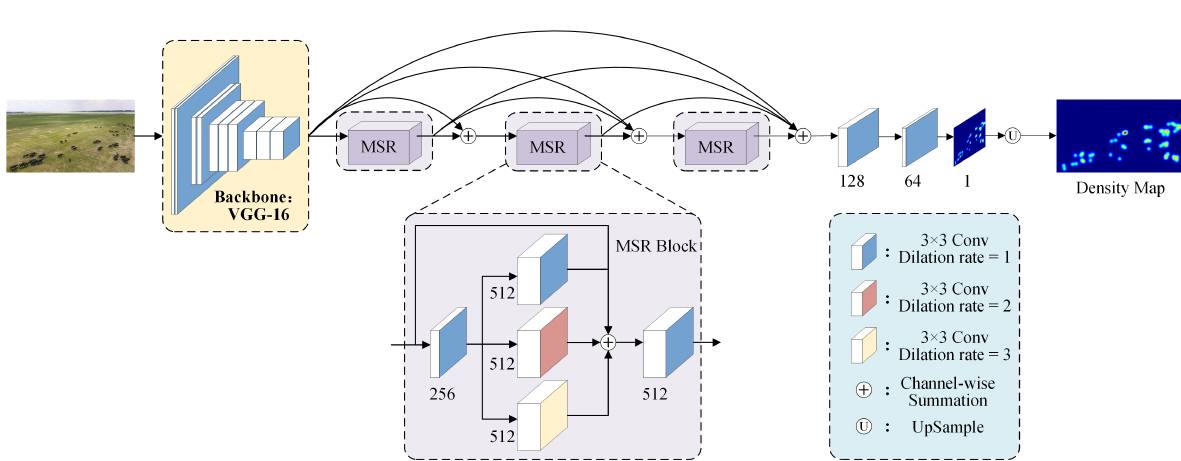
Figure 2. An illustration of our framework of